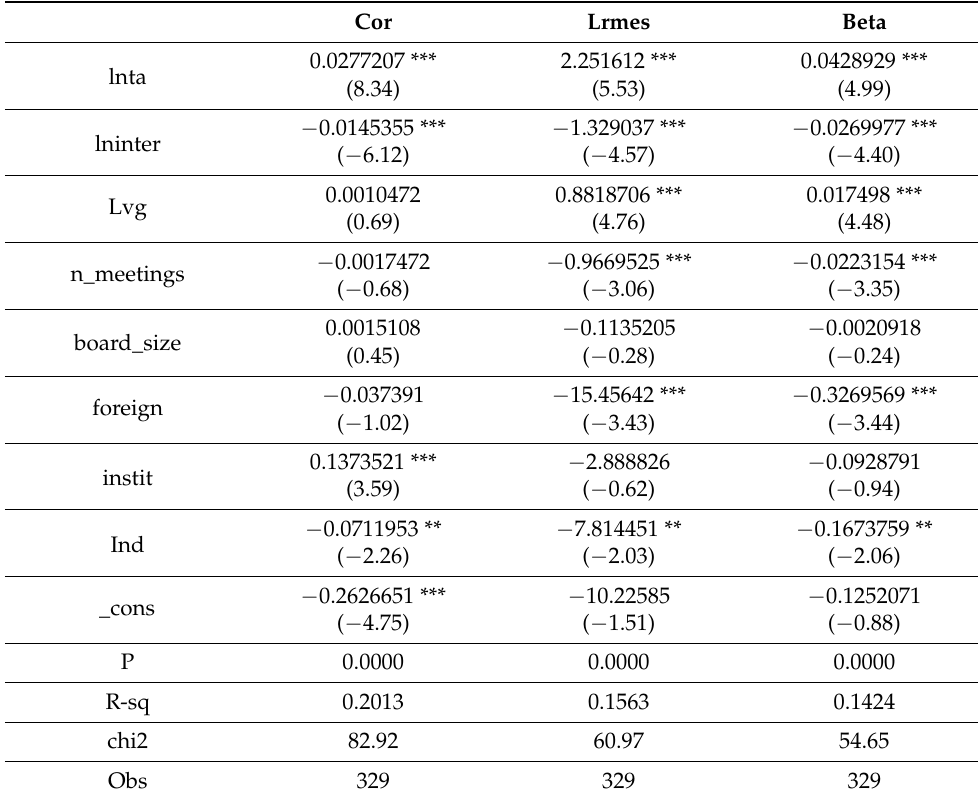
Table 5. Corporate governance and systemic risk (three-stage least